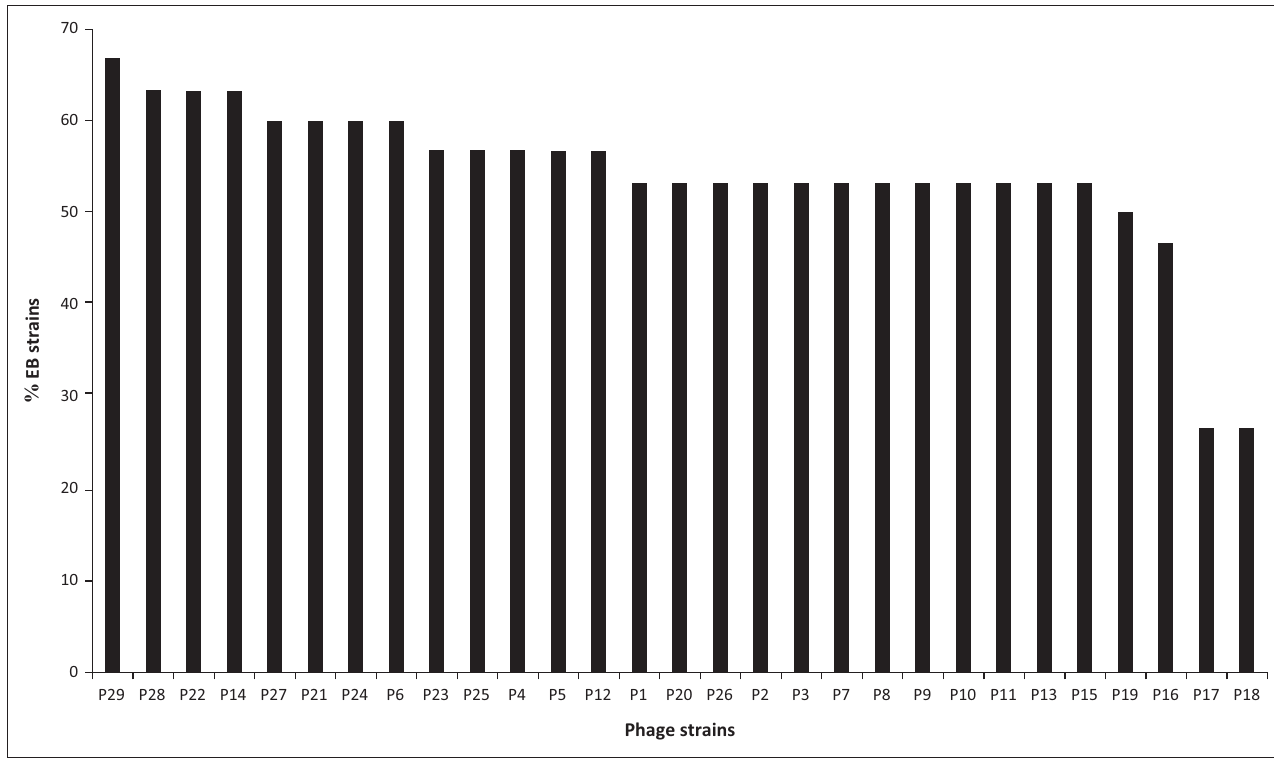
Note: A phage was termed potent upon lysing any bacterial strain in the panel. All the phages ( n = 29) showed cross-reactivity against all Enterobacter cloacae strains ( n = 30) with the most potent phage with the widest spectrum of lysis activity lysing 67 % of the bacterial strains and the least potent phage lysing 27 % of the bacterial strains. FIGURE 6: Percentage potency of isolated phages on Enterobacter cloacae strains isolated in Nairobi County, Kenya, July 2019 to December